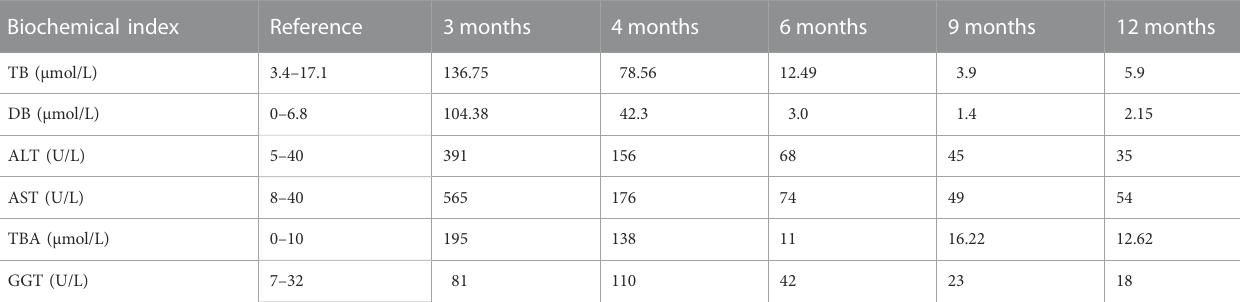
TABLE 1 Liver biochemical pro fi le of the patient.